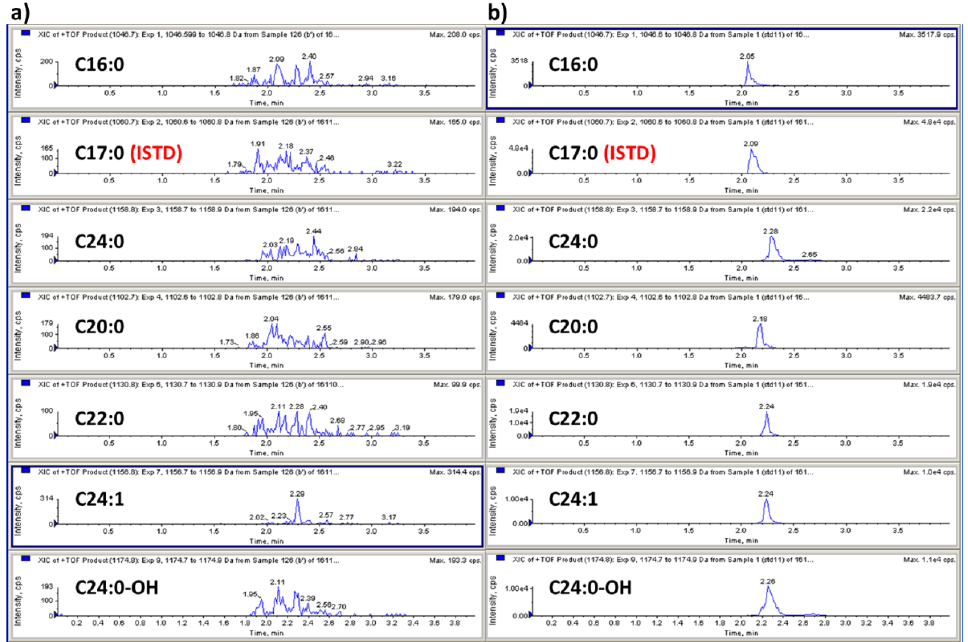
Figure 4. ( a ) LC-MS chromatograms of blank plasma, and ( b ) LC-MS chromatograms of GB3 spiked plasma.